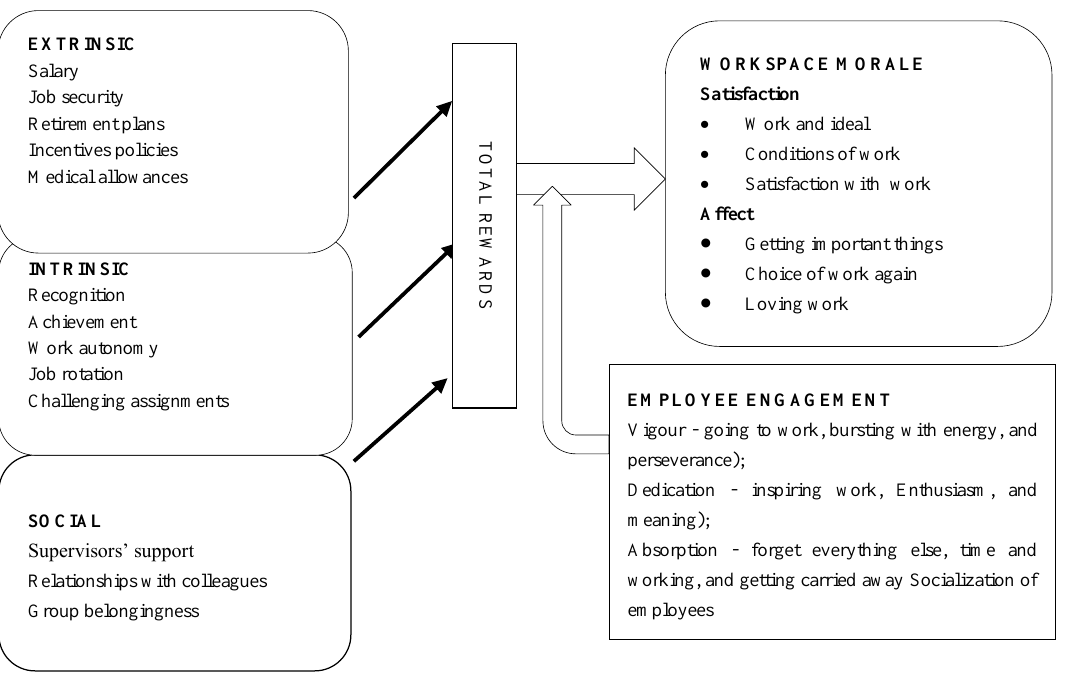
Figure 1: Conceptual Model of the Study; Source: